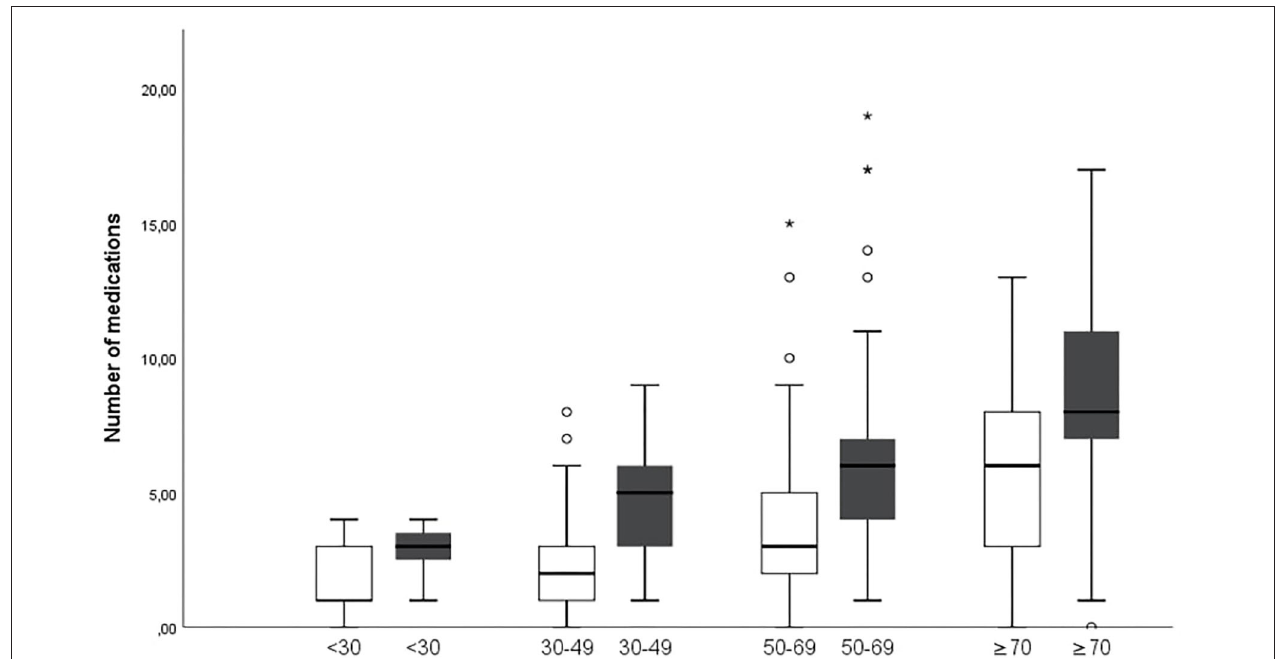
FIGURE 2 | Numbers of medications increase in age groups over 30 years between first (white) and last (gray) visit ( p = 0.001 for age groups 30–49 and 50–69 years and p = 0.014 for age group ≥ 70 years. *Describes major statistical outliers outside of three times the interquartile range. The symbol is used by SPSS as outlined in the methods